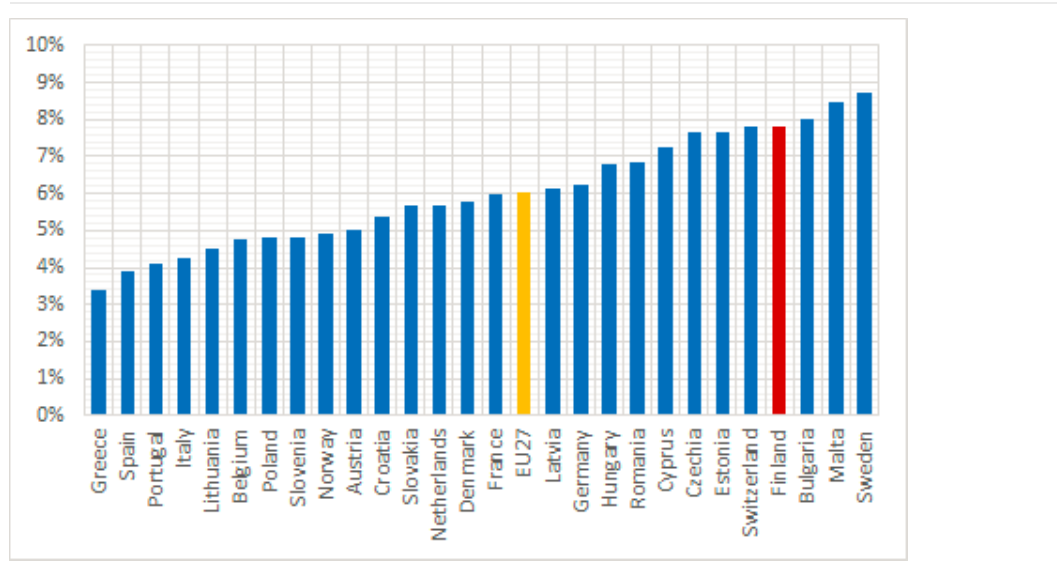
FIGURE 1: Share of ICT activities in gross value added (2019) (EUROSTAT,